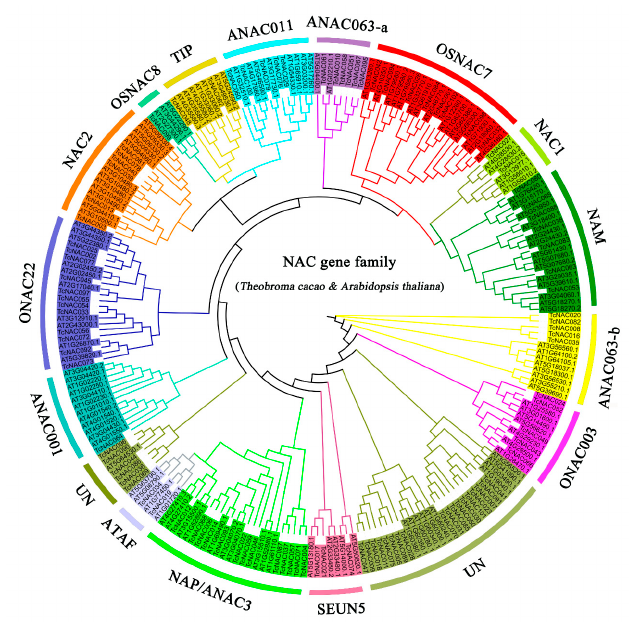
Figure 1. Phylogenetic tree of NAC (NAM, ATAF1/2 and CUC2) domain protein from Arabidopsis and Theobroma cacao . The phylogenetic tree was constructed using the maximum parsimony (MP) method with 1000 bootstrap replications. The 16 subfamilies are distinguished in different colors, and the unclassified TcNACs are represented by the abbreviation “UN”.